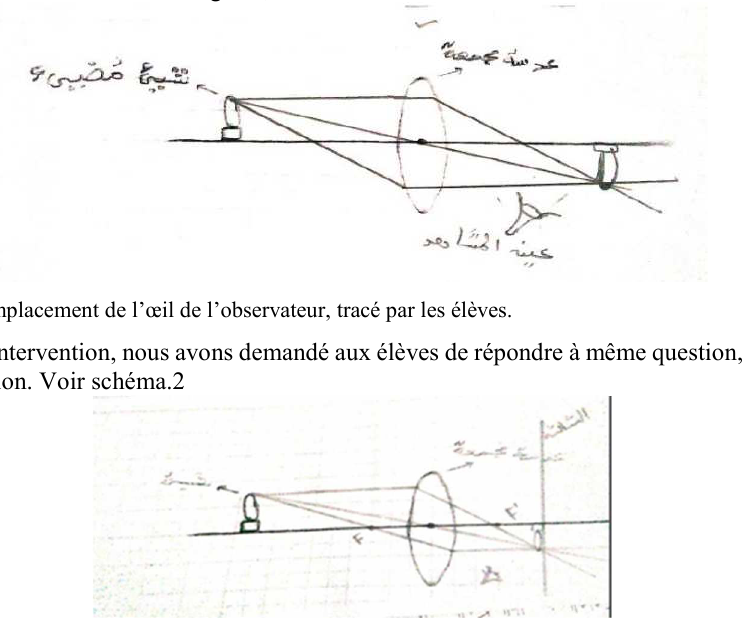
Figure .2 l’emplacement de l’œil de l’observateur, tracé par les élèves De plus, les résultats montrent que les élèves ont des conceptions erronées sur